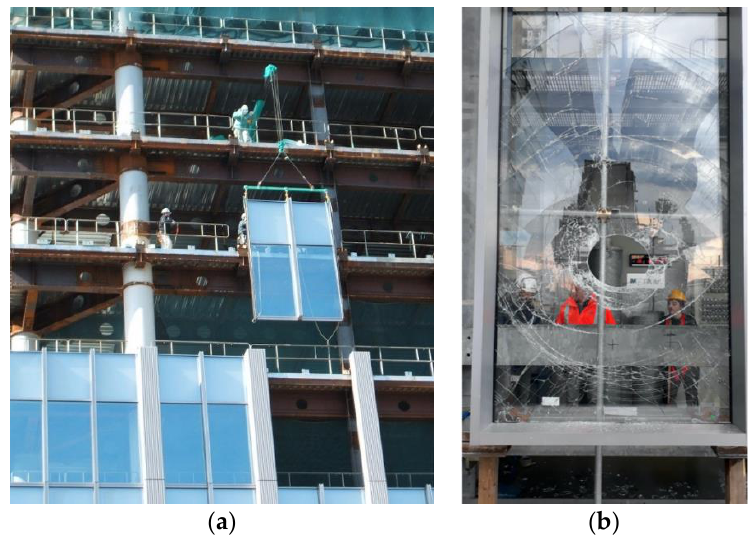
Figure 1. Example of curtain wall: ( a ) modular unit and ( b ) failure under impact.